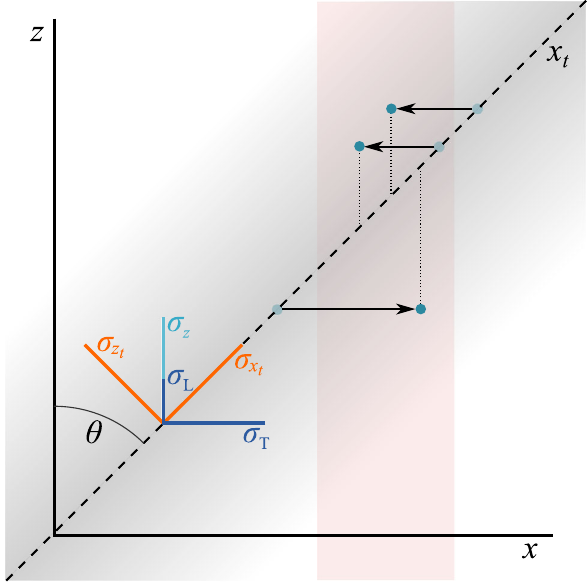
Fig. 5 An illustration of the projection effect whereby transverse dif- fusion leads to smearing on the longitudinal axis (and vice versa) for inclined